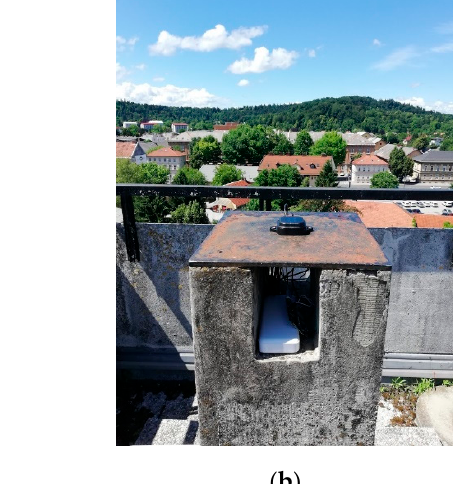
Figure 2. Faculty of Civil and Geodetic Engineering building.